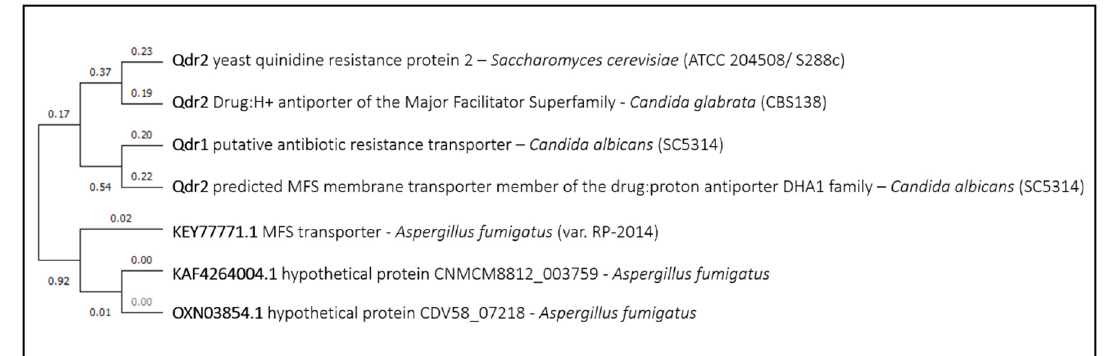
Figure 8. Qdr2 phylogenetic analysis. The tree with the highest log likelihood is shown. This analysis involved seven amino acid sequences. There were a total of 941 positions in the final dataset. Evolutionary analyses were conducted in MEGA X.